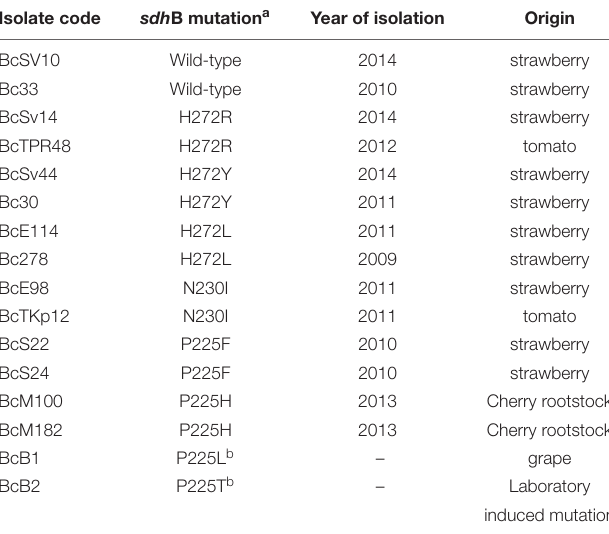
TABLE 1 | List of Botrytis cinerea isolates used for the development of the assay. Isolate